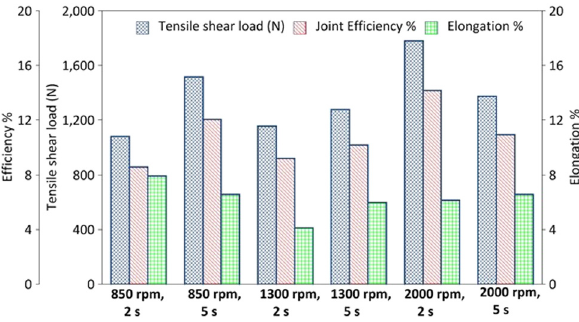
Figure 4: Tensile shear load ( N ) , elongation ( % ) , and e ffi ciency ( % ) of